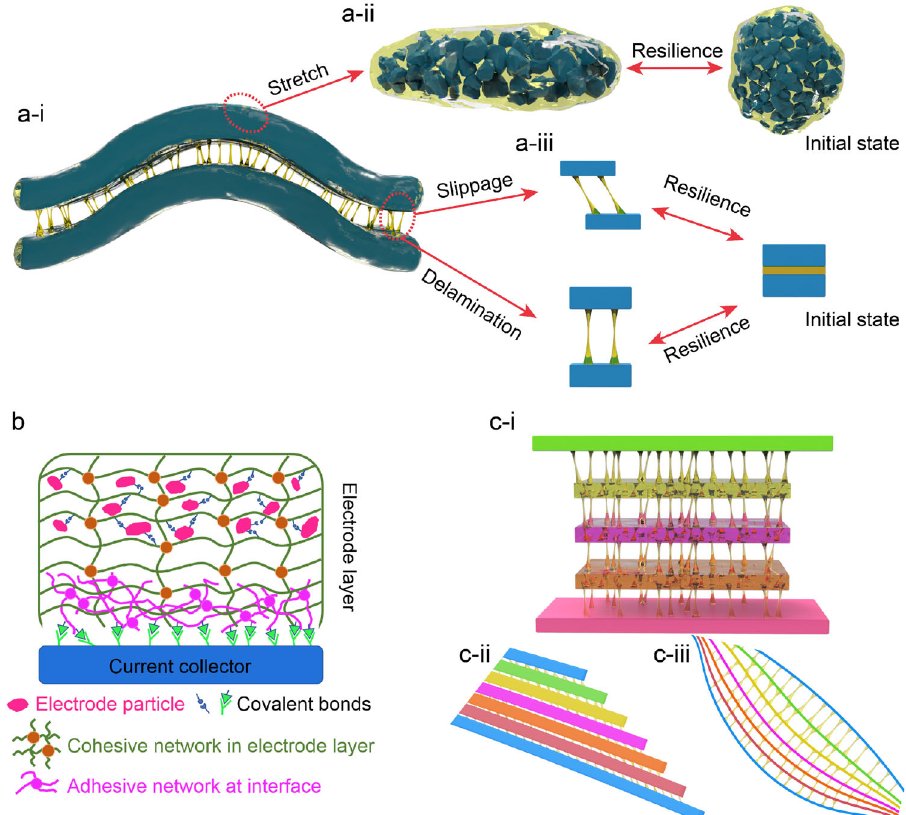
Fig. 2 Schematic illustration of cohesion and adhesion existed in the deformable battery. a -i Applying robust binders to improve cohesive force in electrode layer, where the polymeric network of binders tightly wrapping around electrode particles. Internal cohesion ( a -ii) and interlayer adhesion ( a -iii) with strong resilience to preserve original structure after deformation. b Illustrations on the bonding chemistry between the exempli fi ed two-layered con fi gurations, i.e., electrode layer and current collector. Cohesive network is originated from the binders inside the electrode layer and the adhesive layer is based on the design principle of topological adhesion. c -i The schematic of all-in- one con fi guration with cohesion and adhesion by the same binder, forming chemically adhesive bonds throughout the battery device. Adhesions to inhibit the deformation of slippage ( c -i) and delamination ( c -ii) during